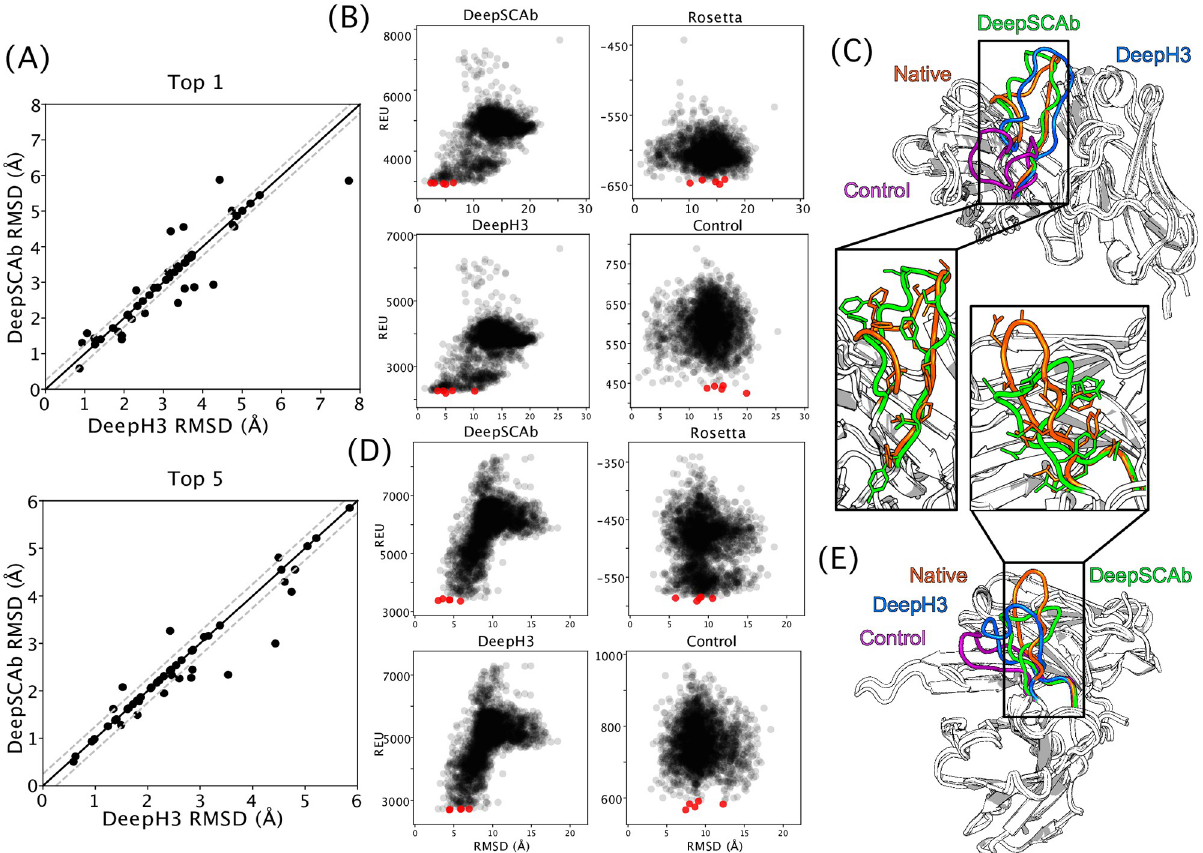
Fig 3. Comparison of CDR H3 structure prediction accuracy. The accuracy with which DeepSCAb, DeepH3, and the control network predict the CDR H3 loop structure is measured via decoy structure scoring tasks. (A) In Top 1-scoring decoy structures (top) and Top 5-scoring structures (bottom), the performance of DeepSCAb is compared to DeepH3 using the test set. (B) The CDR H3 energies for the three methods and Rosetta (ref2015) that correspond to 2FB4 are plotted against their RMSD. The five best scoring structures for each plot are indicated in red. (C) The best prediction from Top 5-scoring decoys for target 2FB4 are shown for DeepSCAb (green, 2.34 Å RMSD), DeepH3 (blue, 3.535 Å RMSD), and the control network (purple, 13.091 Å RMSD) all compared to the native (orange). (D) The CDR H3 energies for the three methods and Rosetta (ref2015) that correspond to 3MLR are plotted against their RMSD. The five best scoring structures for each plot are indicated in red. (E) The best prediction from Top 5-scoring decoys for target 3MLR are shown for DeepSCAb (green, 2.998 Å RMSD), DeepH3 (blue, 4.432 Å RMSD), and the control network (purple, 7.441 Å RMSD) all compared to the native